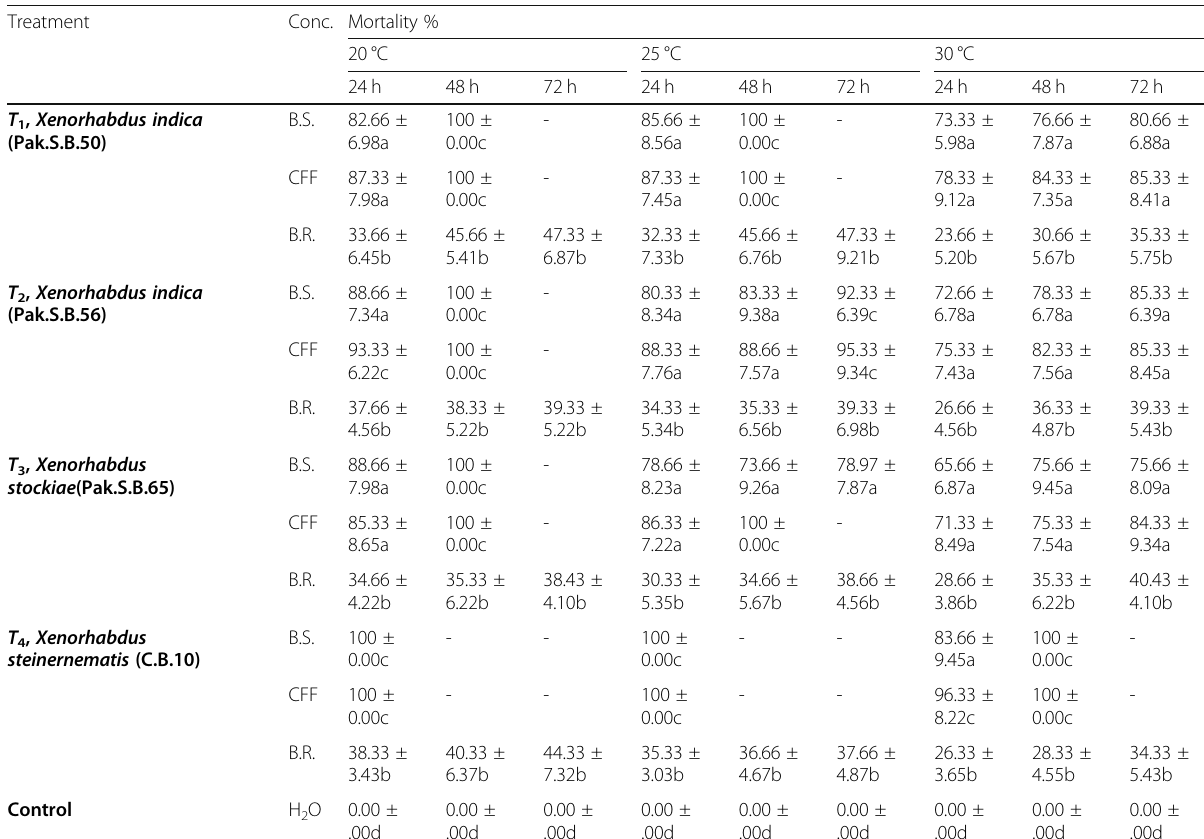
Table 4 Influence of different bacterial fractions on the mortality of termites in relation to temperature and time duration by sand barrier assay method